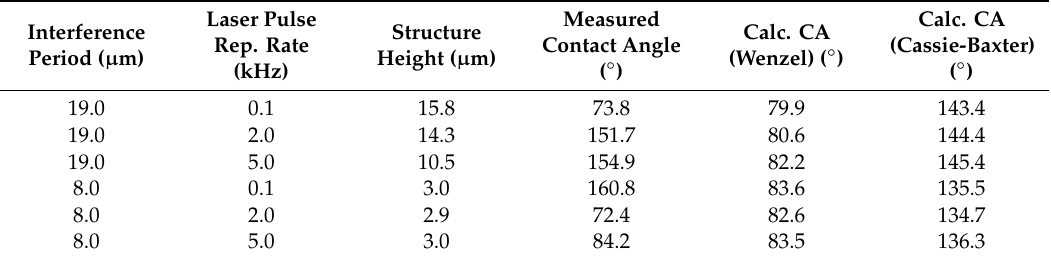
Table 2. Comparison of selected measured contact angle (CA) with theoretical values calculated according to Wenzel and